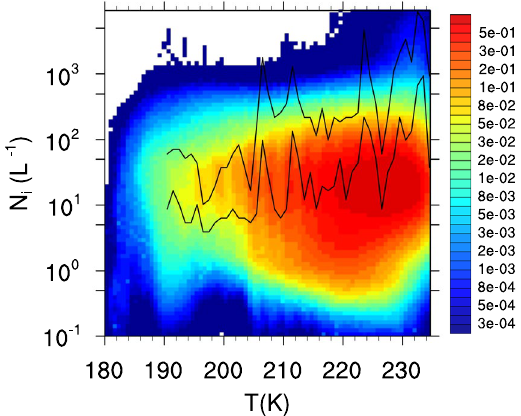
Figure 9. Global frequency distribution of in-cloud ice crystal number concentration as a function of temperature from GEOS-5 output over a 2-year subset (2005–2006). Solid lines represent the 25% and 75% quantiles from a compilation of field campaign observations 23